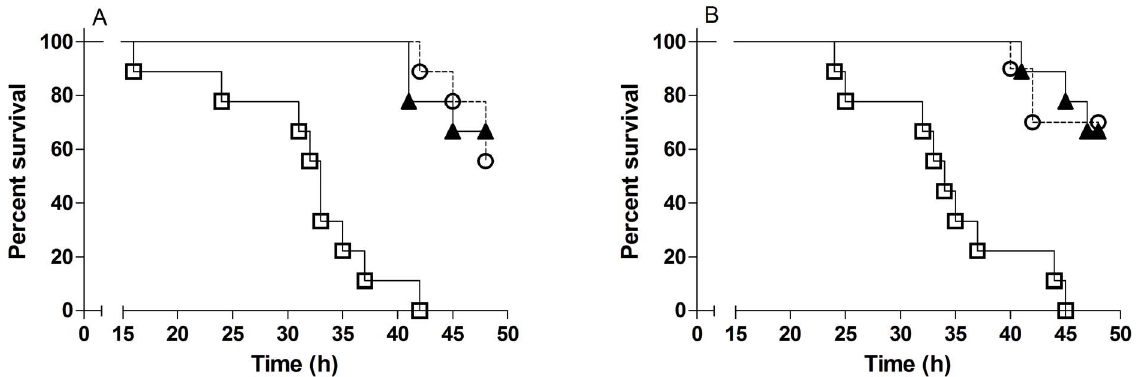
Figure 6. Survival curves after challenge of infant mice. Infant mice (9–10 mice per group) were challenge with Inaba (A) or Ogawa (B) bacteria mixed with pooled serum from adult CD1 mice orally immunized with formalin–killed MS1568 (open circles with dashed lines), Dukoral (triangles) or as control serum from unimmunized mice (open squares). Results show that mice challenged with either Inaba or Ogawa bacteria mixed with serum from MS1568 and Dukoral, respectively, had reduced mortality (p , 0.0001) compared to mice challenged with bacteria mixed with control serum.